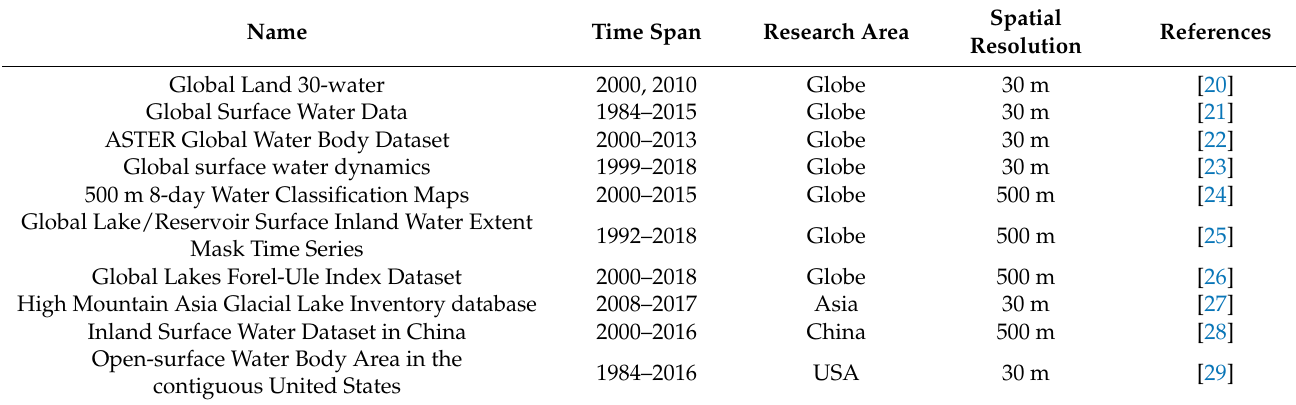
Table 1. Several typical water remote sensing